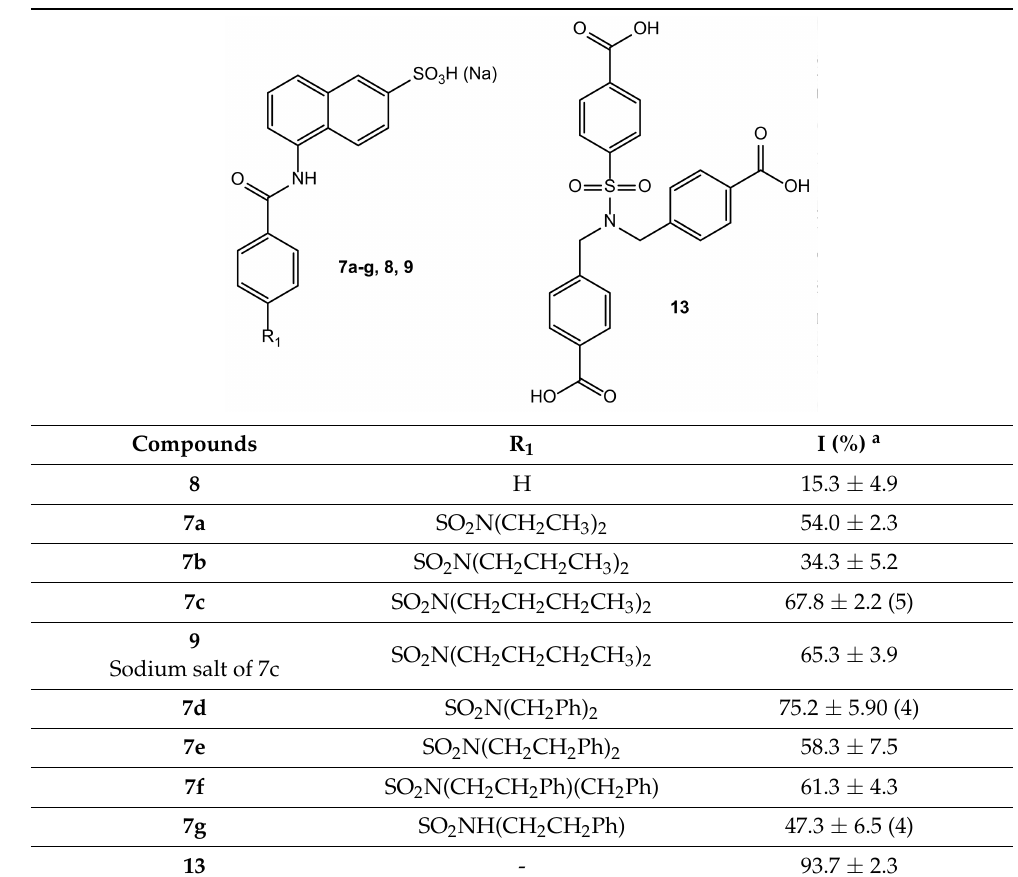
Table 2. Inhibition (%) values of compounds 7a – g , 8 , 9 and 13